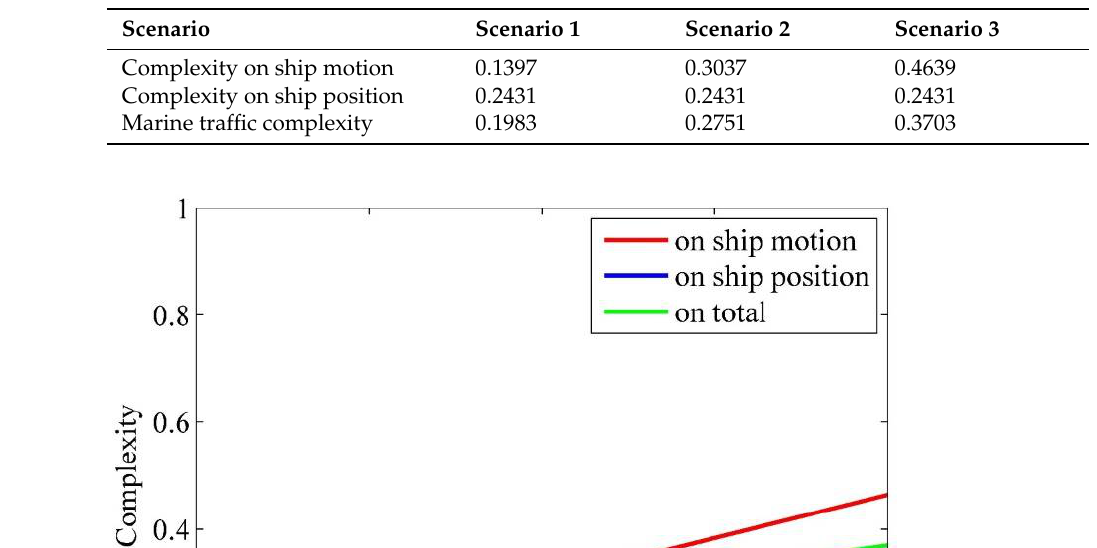
Table 1. The results of the first simulated case study.